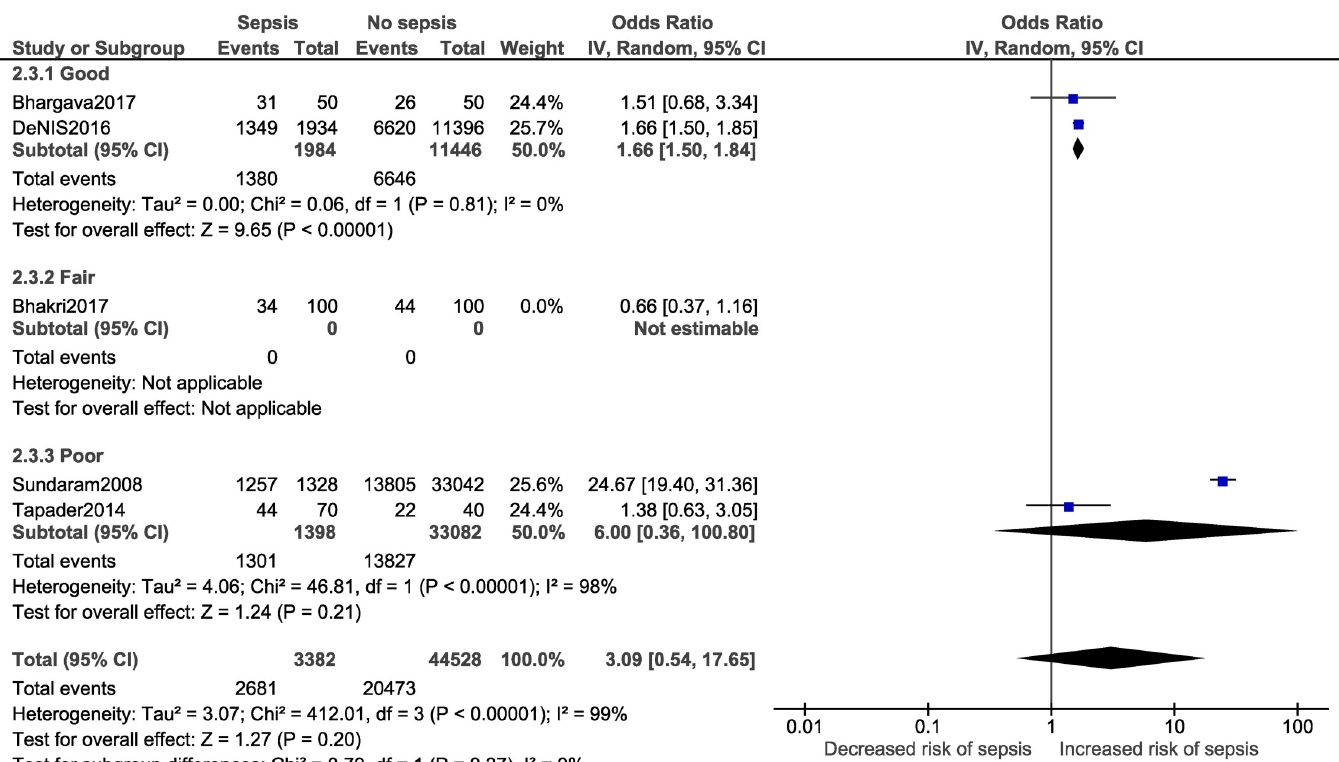
Fig 16. Forest plot showing random-effects meta-analysis for low birth weight ( < 2500 grams) neonates with and without sepsis, sub-grouped by study quality (4 studies) [IV: Inverse Variance; CI: Confidence Interval].